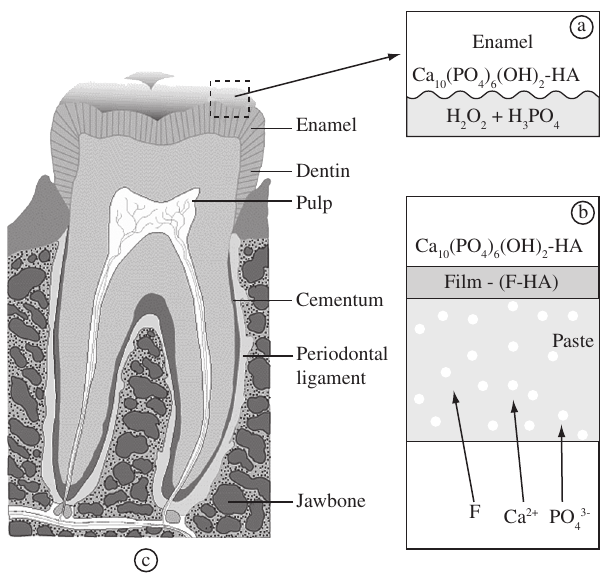
Figure 2. Schematic representation of the F-HA deposition onto tooth surface. a) The first step shows the dissolution of the enamel surface with